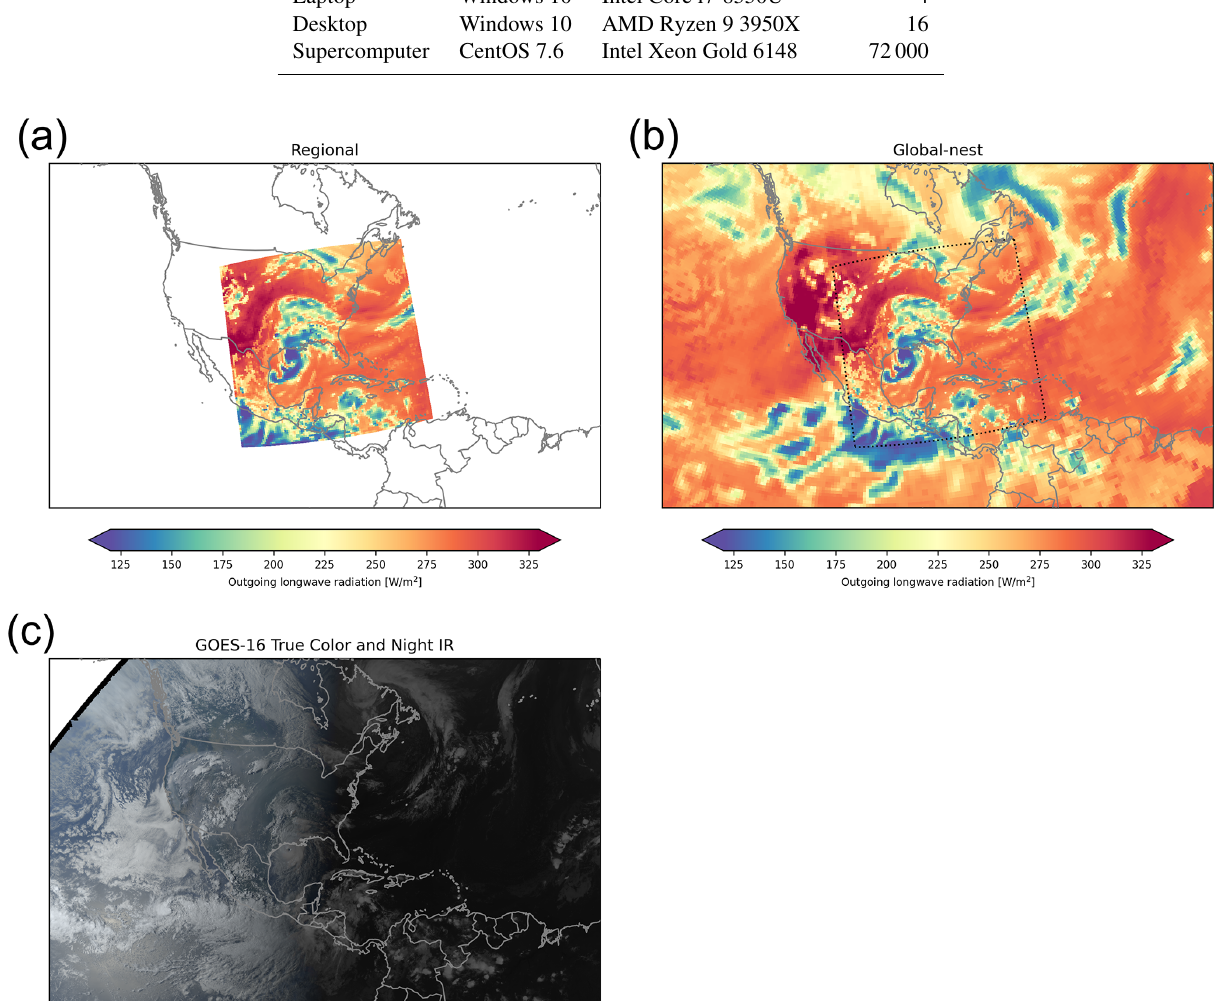
Figure 3. Hurricane Laura simulations versus satellite imagery. Panel (a) and (b) show outgoing longwave radiation simulated by SHiELD as a region and a global–nest model, respectively. Both are a snapshot at 00:00UTC on 27 August 2020, 12h into the simulation. The dotted box represents the boundaries of the nest domain. Panel (c) shows the Geostationary Operational Environmental Satellite-16 true color and night infrared imagery 10min after 00:00UTC on 27 August